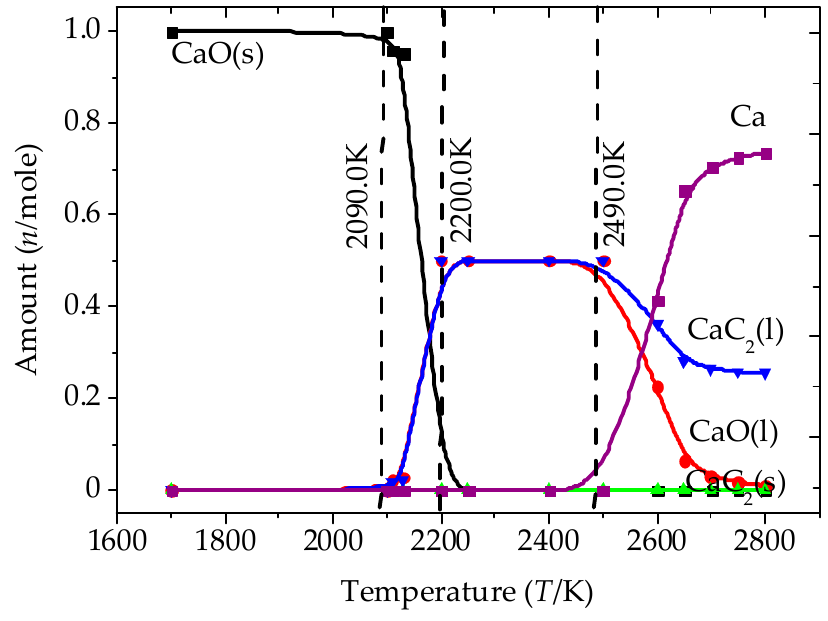
Figure 18. The equilibrium phase composition at each reaction temperature.